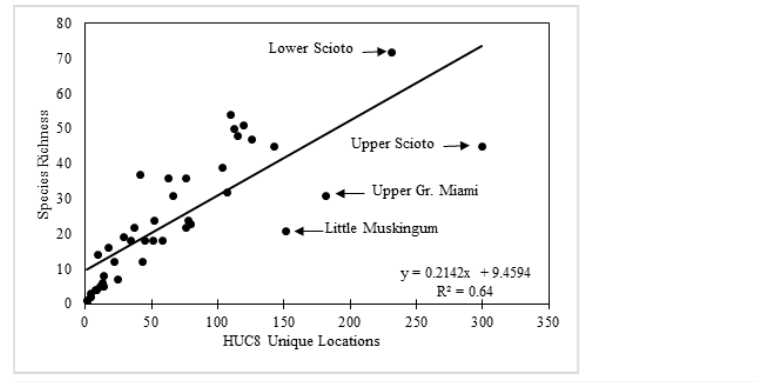
Surface area of HUC8 drainages appears to be an unimportant predictor of stone fl y species richness (Fig. 3). One point is well above the line-of-best- fi t, that of the Lower Scioto drainage. It is the richest, despite not being the largest, HUC8 drainage. Many relatively small HUC8s have high richness, while many intermediate sized drainages support only a few stone fl y species. The number of unique locations sampled within a watershed appears to be a much stronger predictor of stone fl y species richness (Fig. 4). Again, the Lower Scioto drainage exceeds predictions. Conversely, the Upper Scioto, the Upper Greater Miami, and Little Muskingum drainages all fall below the line-of-best- fi t. These drainages are either largely agricultural, have high industrialization, or have large human populations in them, all conditions that would lead to lower than expected stone fl y richness.